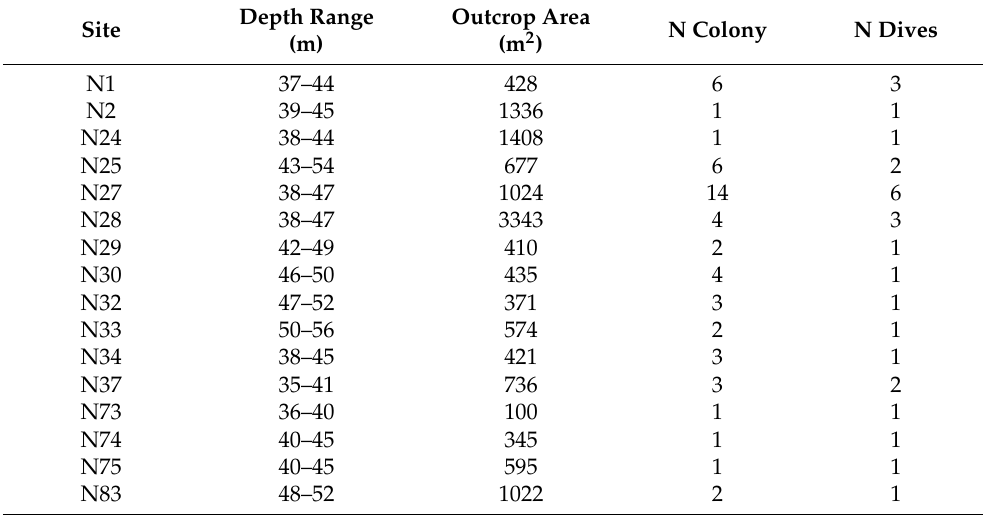
Table 1. Investigated sites with the occurrence of Eunicella verrucosa within the Tavolara–Punta Coda Cavallo Marine Protected Area and number of specimens in each one. Coordinates of the sites can be consulted upon request to the Marine Protected Area